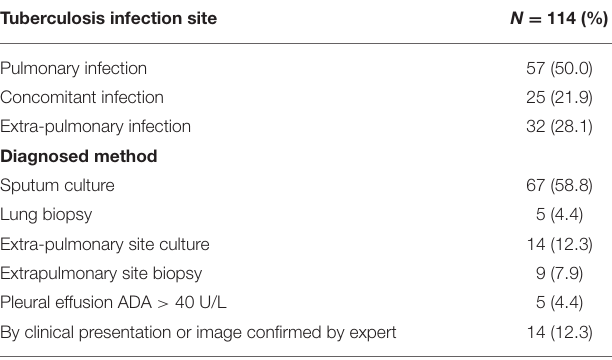
TABLE 2 | Clinical characteristics of tuberculosis